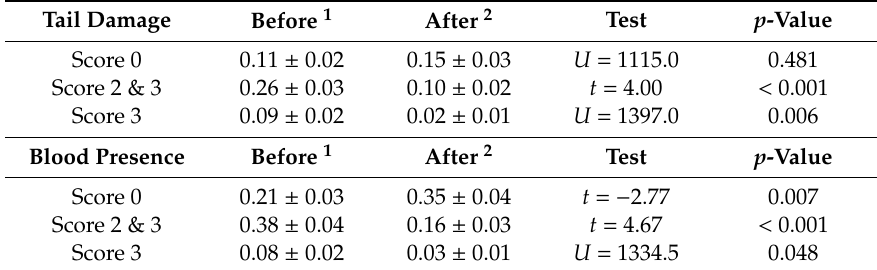
Table 4. Proportion of pigs (mean ± s.e.) with di ff erent levels of tail damage and blood presence scores recorded before the onset of outbreaks and after outbreaks were